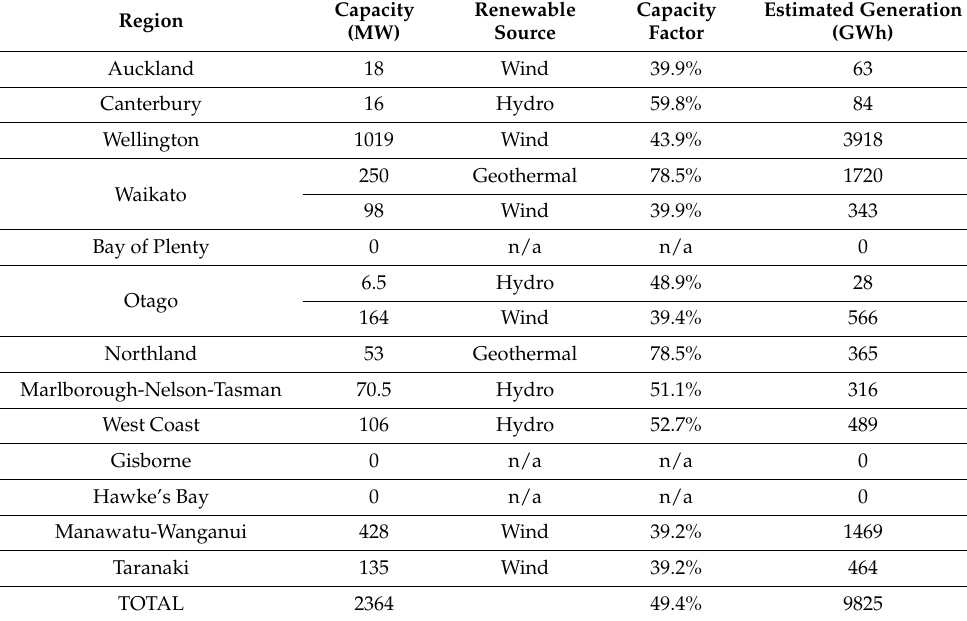
Table 3. Consented yet unbuilt renewable energy projects per